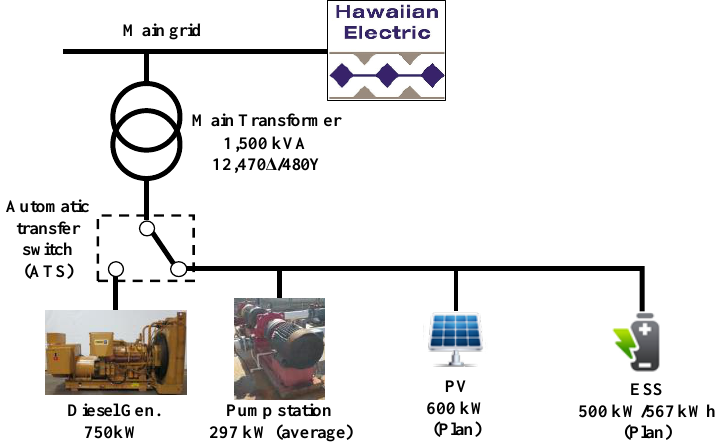
Figure 1. Natural Energy Laboratory of Hawaii Authority (NELHA) microgrid configuration (the photovoltaic (PV) and the energy storage system (ESS) are planned to be installed).